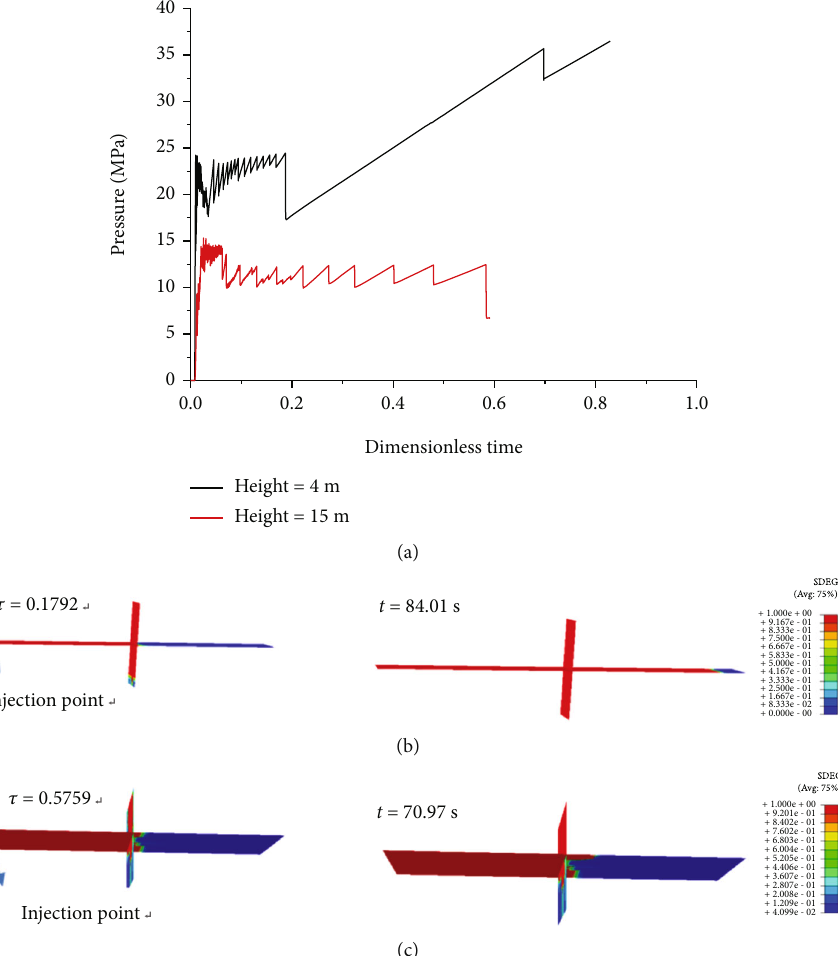
Figure 14: The numerical results between 4m and 15m formation thickness with an approaching angle of 90 degrees: (a) the fl uid pressure history at the injection point; (b) fracture opening contours and crack propagation paths at the corresponding time (deformation scale factor is